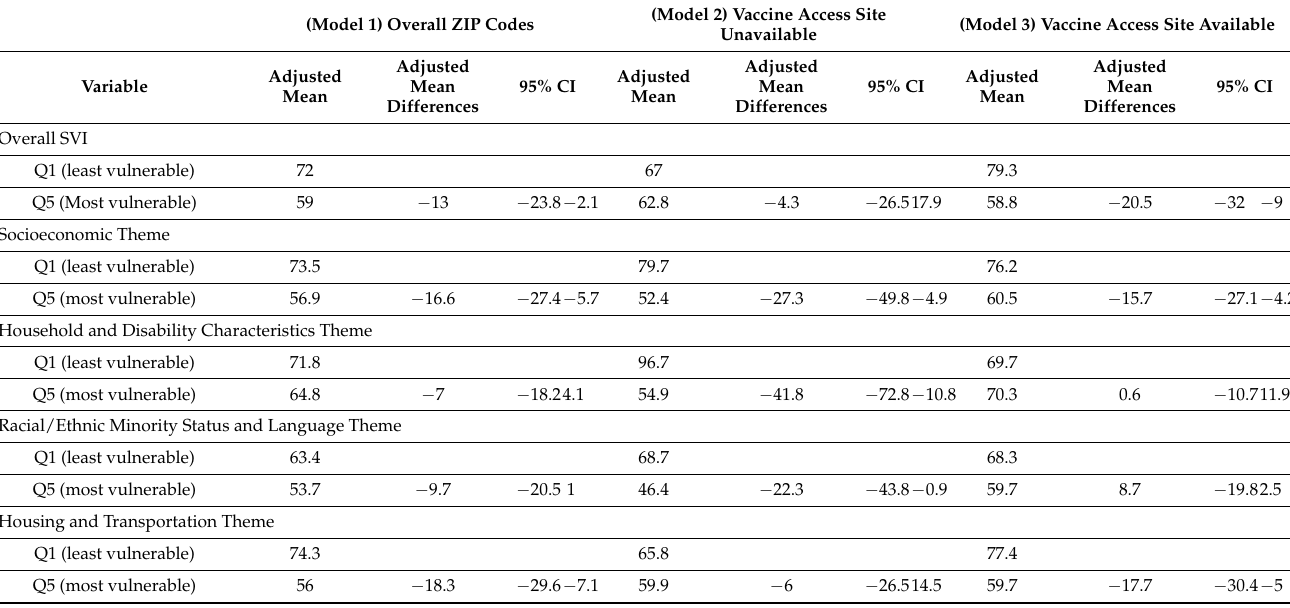
Table 2. Association differences in COVID-19 vaccine coverage between the least (Q1) and most (Q5) vulnerable ZIP codes stratified by the availability of a designated COVID-19 vaccine access site a . (Model 1) Overall ZIP Codes (Model 2) Vaccine Access Site Unavailable (Model 3) Vaccine Access Site